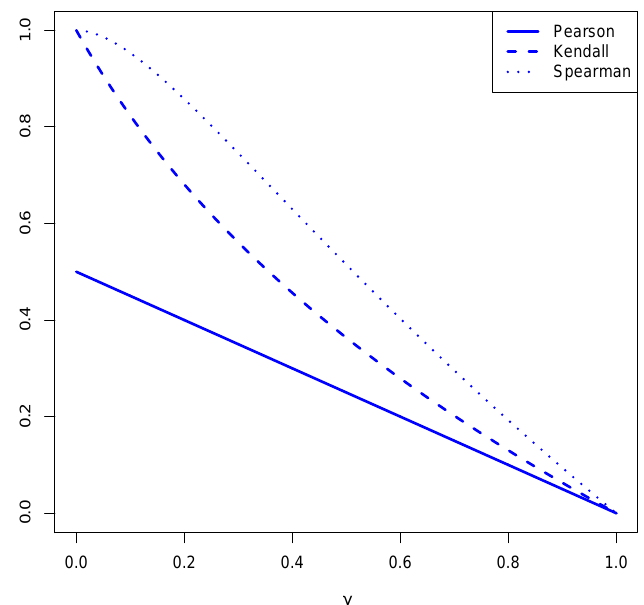
Figure 2. The plot of the Pearson rho, Kendall tau, and Spearman rho measures of correlation for varying values of γ ∈ ( 0,1 )